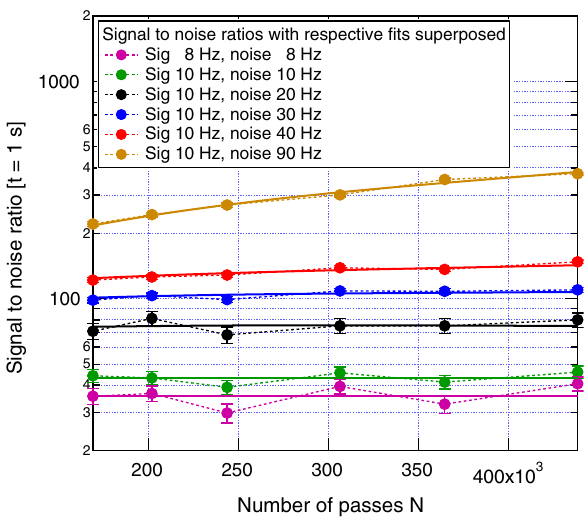
Fig. 13 Signal-to-noise ratios of the Cotton-Mouton peaks with respect to the noise at different frequencies. The fits take into account the cavity response at the different frequencies according to Eq.